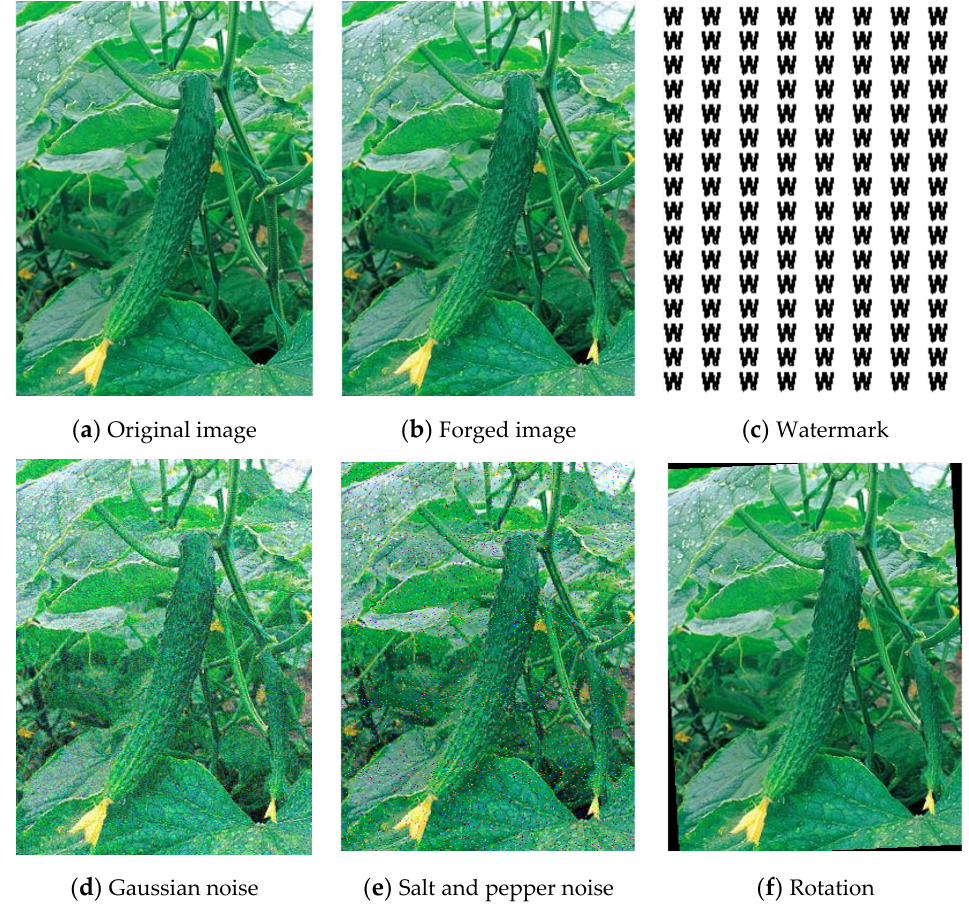
Figure 7. Examples of forged images attacked by some known attacks.